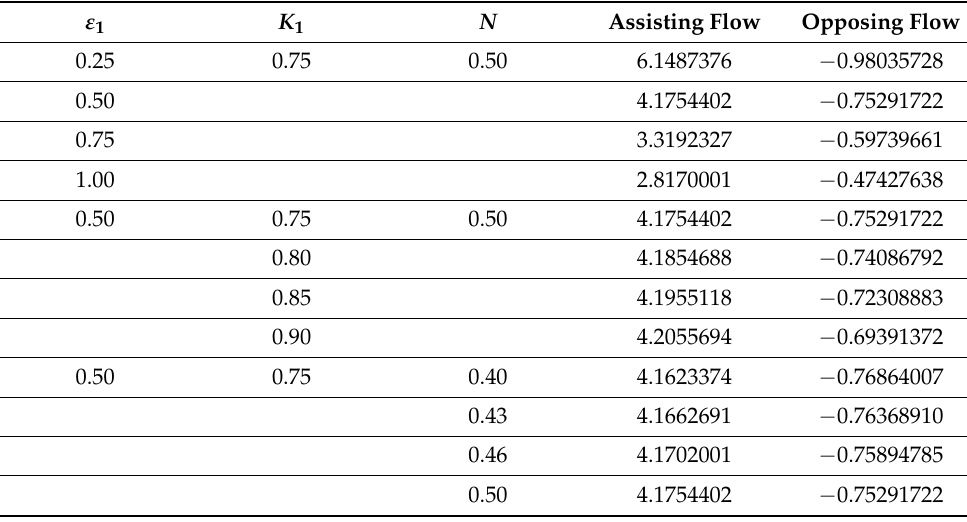
Table 2. Numerical values of shear stress C f for several values of influential parameters.